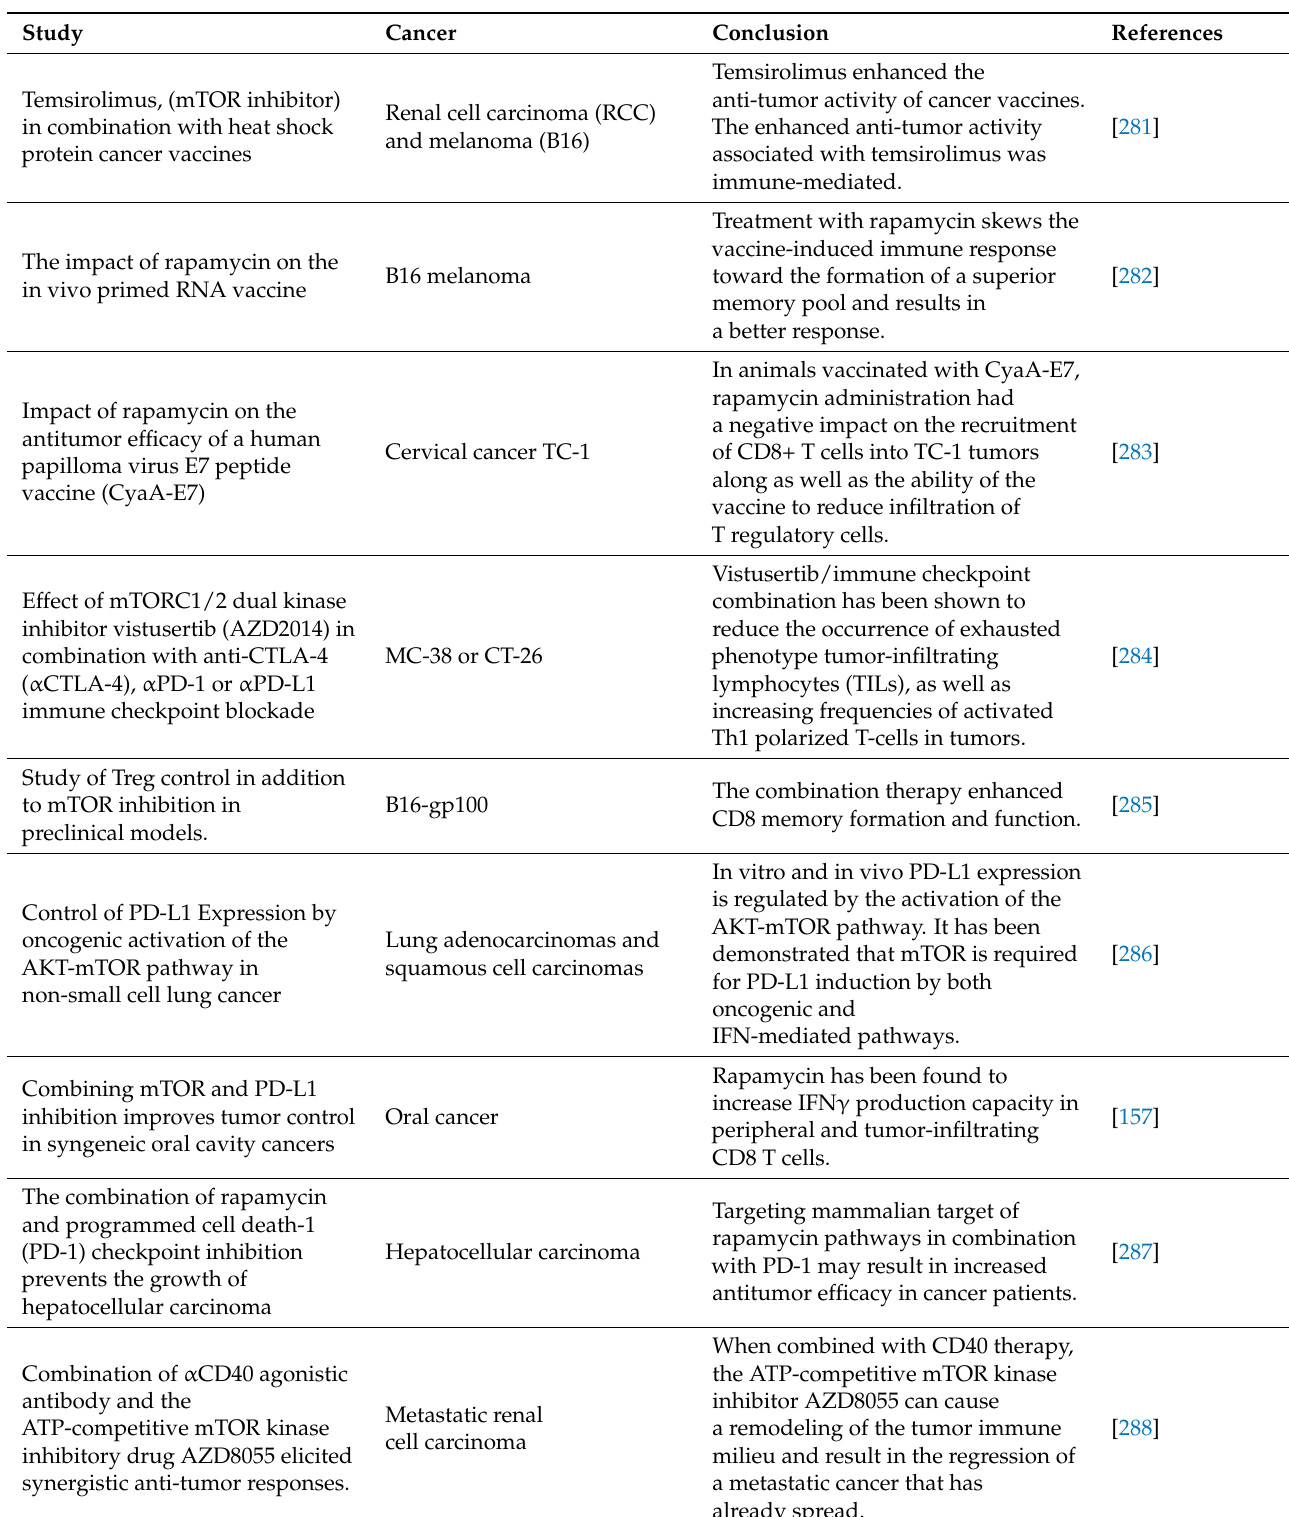
Table 3. mTOR inhibitors in combination with other therapies in different types of